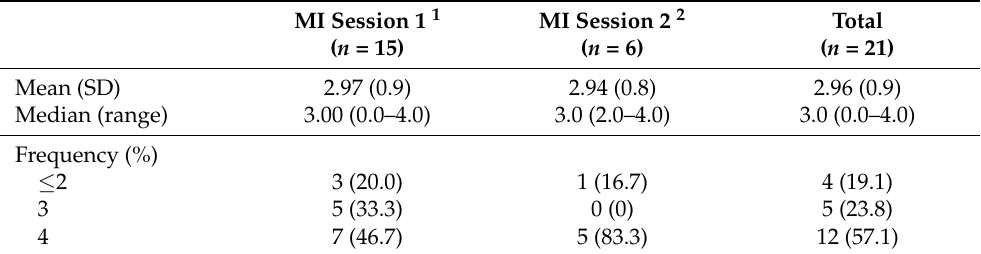
Table 4. The caseworkers’ adherence to the Motivational Interviewing (MI) manual’s main